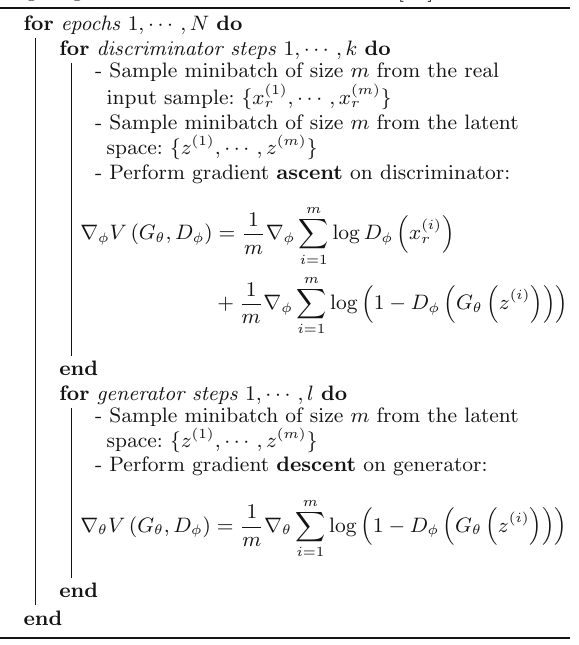
Algorithm 1: Stochastic gradient descent train- ing of generative adversarial networks [23].